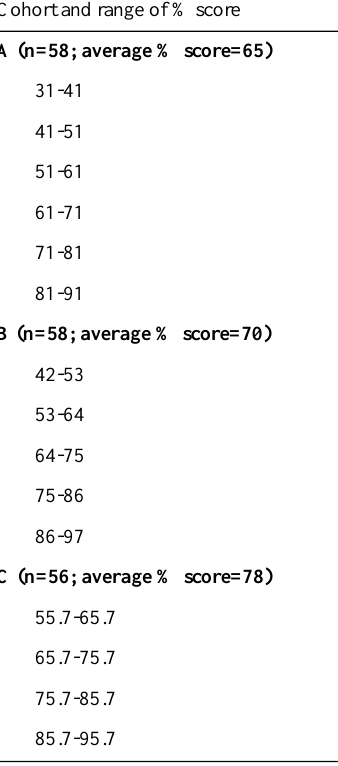
Table 1. Performance of students in the summative assessment of the Head and Neck course across three cohorts: (A) cohort where the course was delivered on-site using traditional didactic pedagogy; (B) cohort where the course was delivered on-site using the blended pedagogical framework with incorporation of dissection sessions; and (C) cohort where the course was delivered using the blended pedagogical framework, with integration of the social media application interactome during the COVID-19–mandated lockdown period. Note: the performance of the students was better when the pedagogical framework was implemented in the delivery of anatomy education. A (n=58; average %